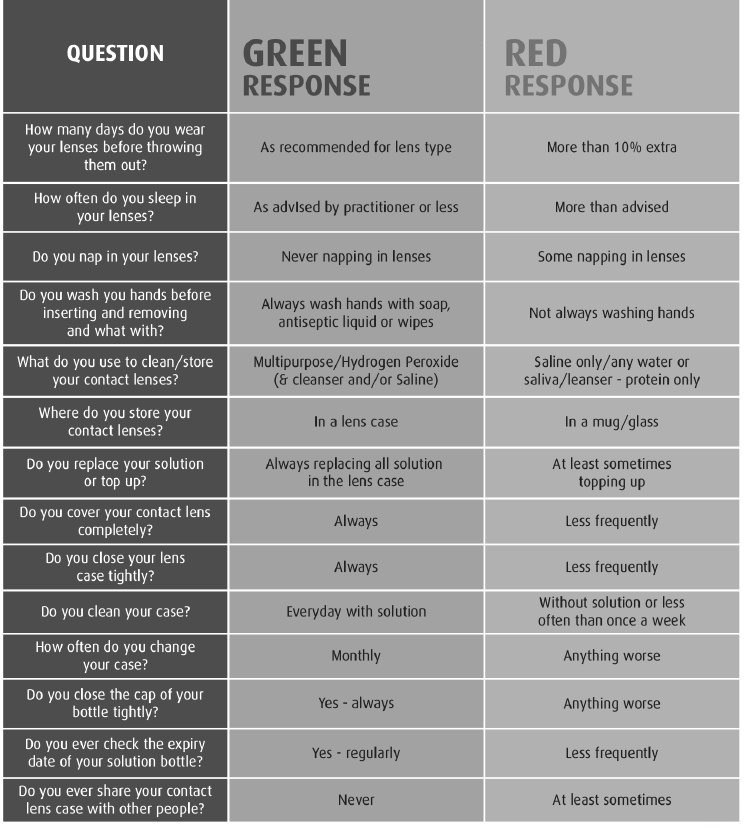
Adapted with permission from from Baush & Lomb, 2010.